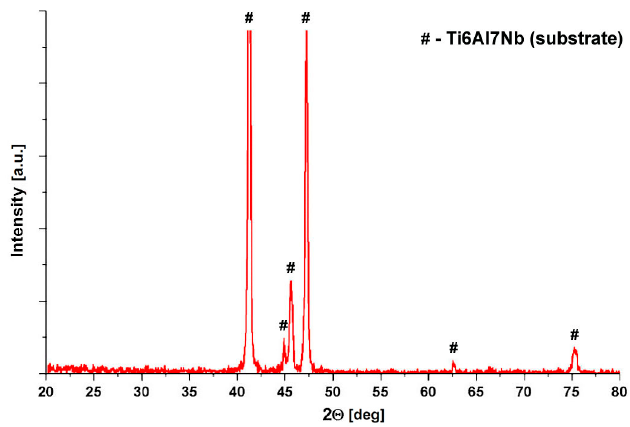
Figure 6. Diffraction pattern of Al 2 O 3 coating deposited on Ti6Al7Nb alloy substrate. Figure 6. Di ff raction pattern of Al 2 O 3 coating deposited on Ti6Al7Nb alloy substrate.